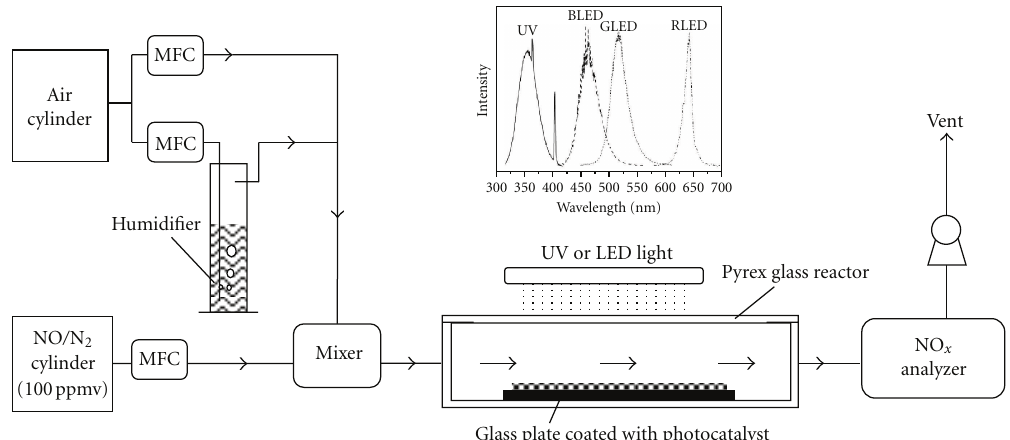
Figure 2: Schematic diagram of De-NO x system. The inset shows photon energy distribution of UV lamp and LEDs.